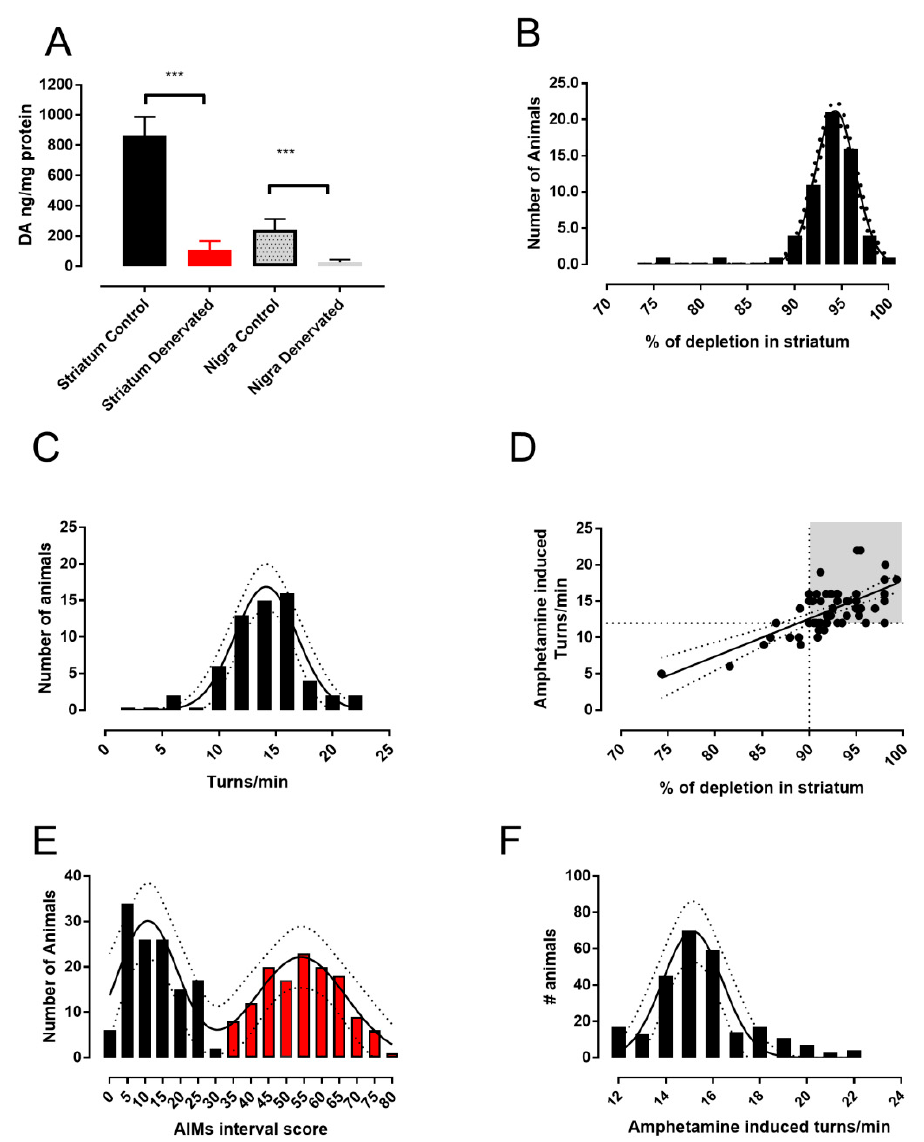
Figure 1. A single uniform 6-OHDA-lesioned population of rats produced two populations with low and high dyskinetic scores during L-DOPA treatment. ( A ) The effect is shown of 6-OH dopamine injected into the MFB on striatal and nigral dopamine content in the ipsilateral and the contralateral sides 17 days after the lesion (mean ± SD). ( B ) The population distribution of the percentage of striatal depletion. ( C ) The population distribution of this set of animals grouped by ipsilateral turns / min induced by a single dose of amphetamine (10 mgrs / kg i.p.) 16 days after the lesion. ( D ) The relationship of the percentage of dopamine depletion vs. amphetamine-induced circling of this set of animals. ( E ) The population distribution of a set of 260 animals selected for the amphetamine challenge with more than 12 turns / min and treated with L-DOPA 10 mgrs / kg i.p. over 20 days, grouped with their AIMs scores. Black bars indicate population one, corresponding to low scores, and red bars corresponding to the second population, corresponding to high scores. ( F ) The population distribution of this same set of 260 animals grouped by ipsilateral turns / min induced by a single dose of amphetamine (10 mgrs / kg i.p.) 16 days after the lesion. Note: *** p < 0.001 with respect to control